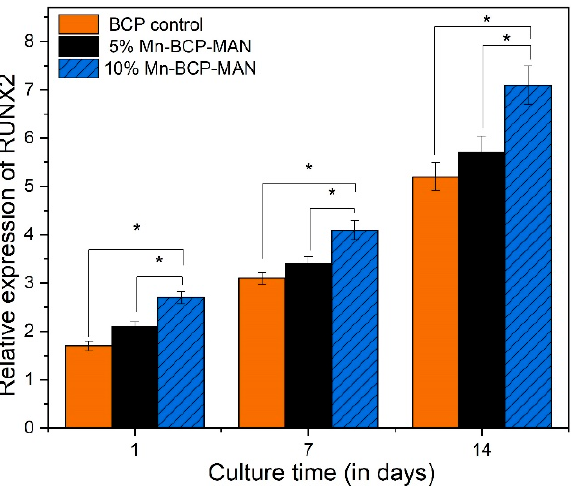
Figure 11. Relative expression of Runt-related transcription factor X2; * denotes p < 0.05.